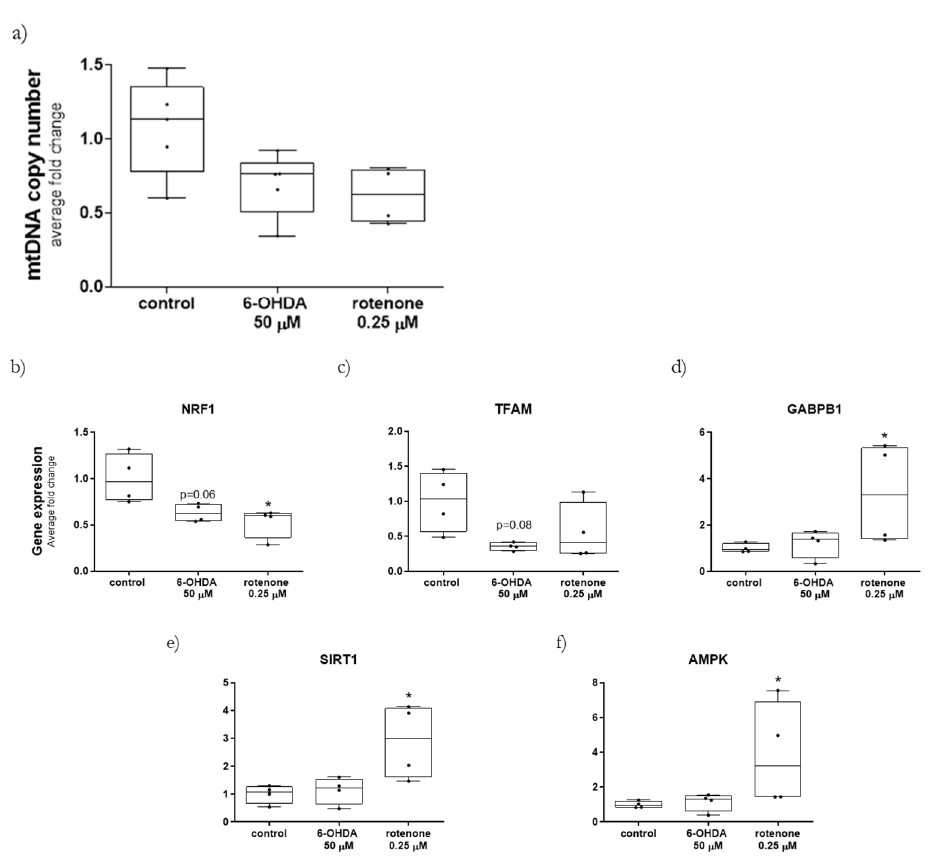
Figure 8. mRNA levels of mitochondrial biogenesis-associated genes and mtDNA copy number were differently affected by 6-OHDA and rotenone. Mitochondria DNA copy number ( a ) and mitochondrial biogenesis-associated genes NRF1 ( b ), TFAM ( c ), GABPB1 ( d ), SIRT1 ( e ) and AMPK ( f ) were measured in cells treated with 50 µM 6-OHDA and with 0.25 µM rotenone for 24 h. Data are represented in boxplots in which each dot represents an independent cell population ( n = 4). Kruskal–Wallis test (one-way ANOVA on ranks) pairwise (control vs. 6-OHDA or control vs. rotenone) was used to assess statistical significance, (*) p < 0.05.